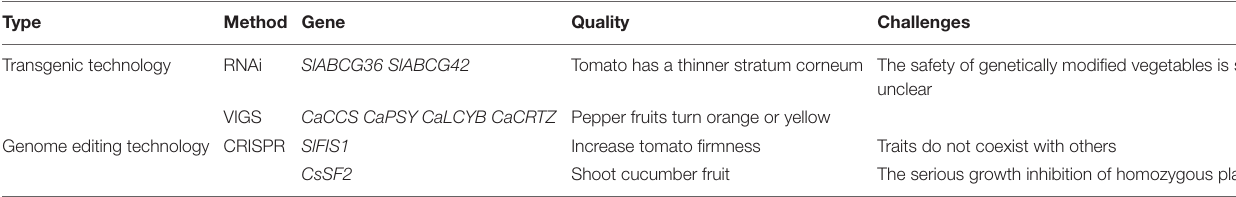
TABLE 2 | Application of transgenic and genome editing technology in